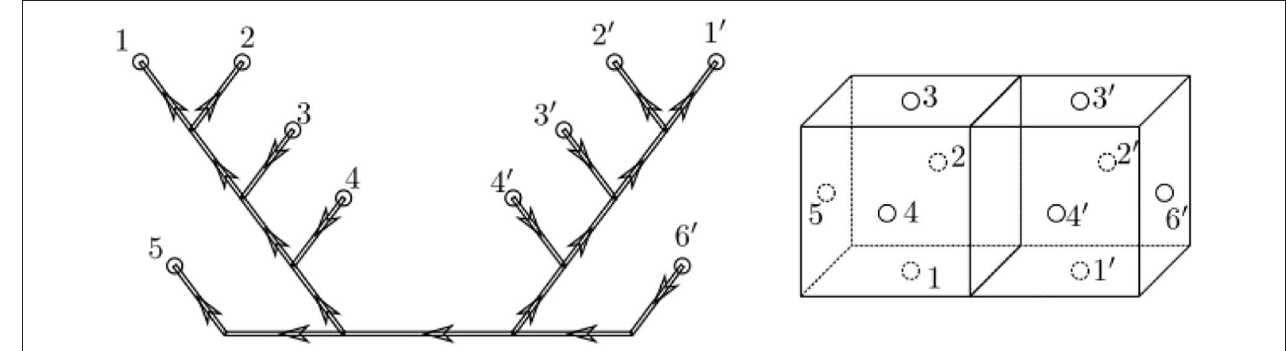
FIGURE 14 | Example for why tree transformations are necessary: after gluing the tree is not suited for coarse graining pairs of punctures i , i ′ . It must be transformed such i , i ′ are directly fused together. See the glued cubes on the right as